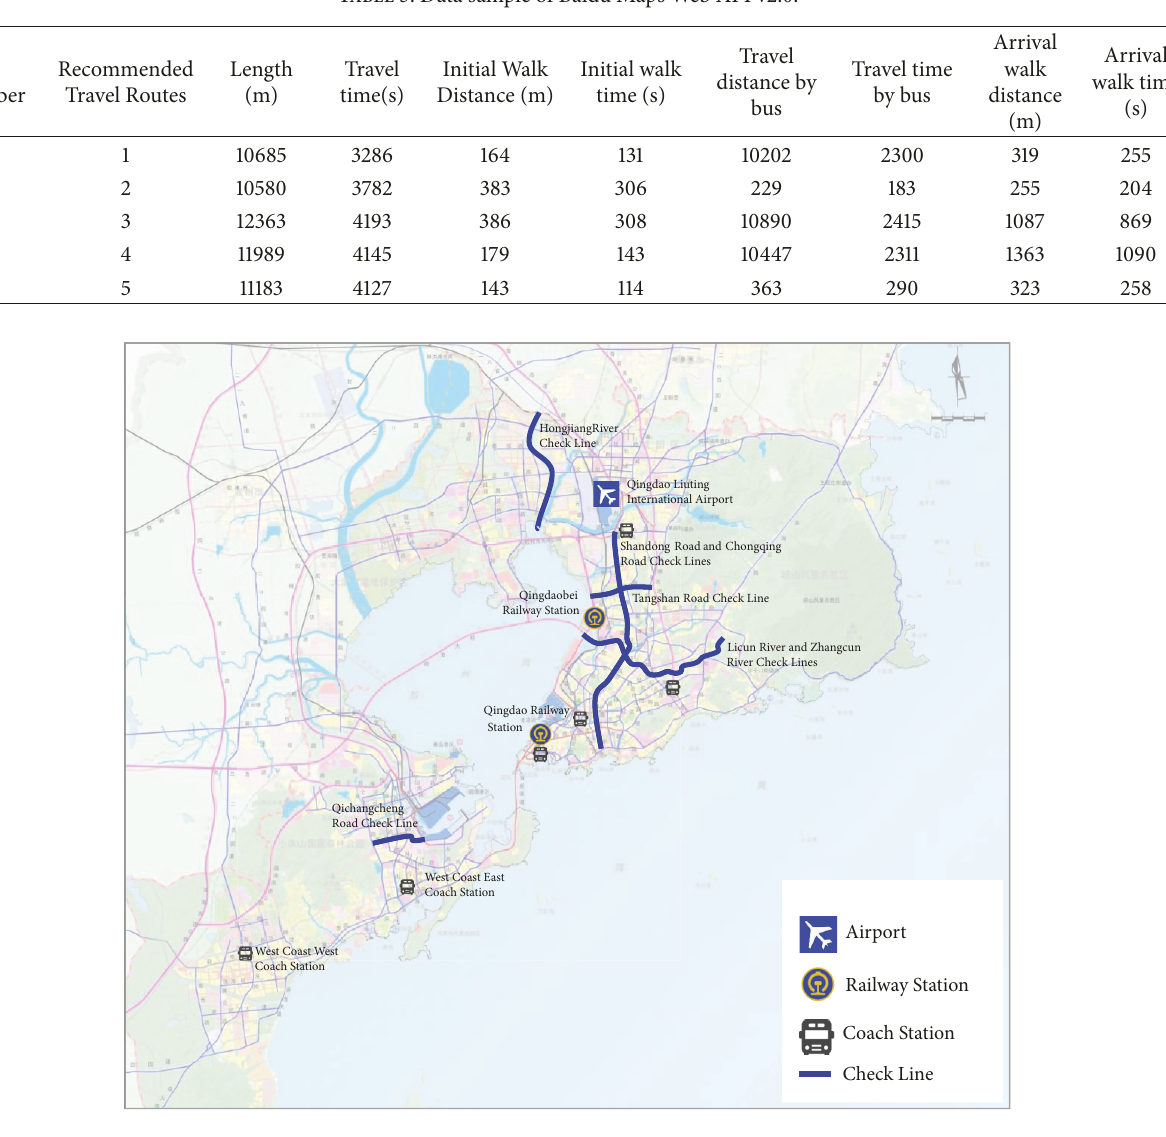
Figure 4: The main traffic survey